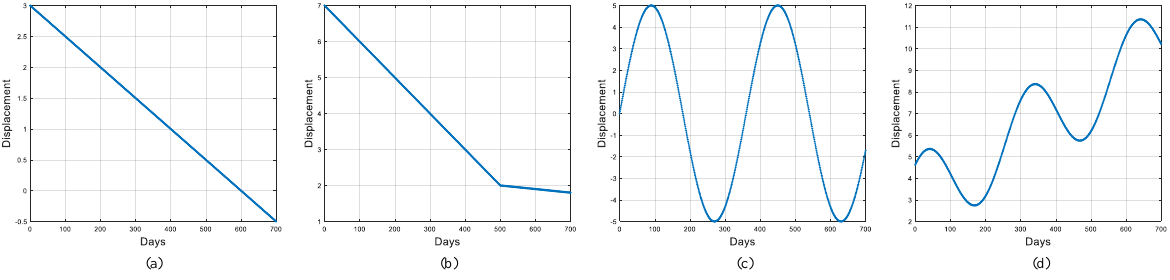
Figure 2 . Exemplary time series plots of a time series with linear trend (a), piecewise linear trend (b), seasonal component (c), and linear trend and seasonal component